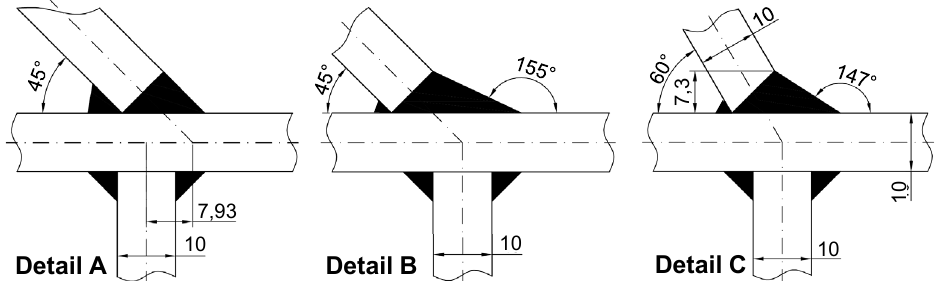
Figure 7: Considered configuration of a sloped upper transverse attachment: with slope angle of 45° and a) eccentric and b) aligned center lines as well as c) with slope angle of 60° and aligned center